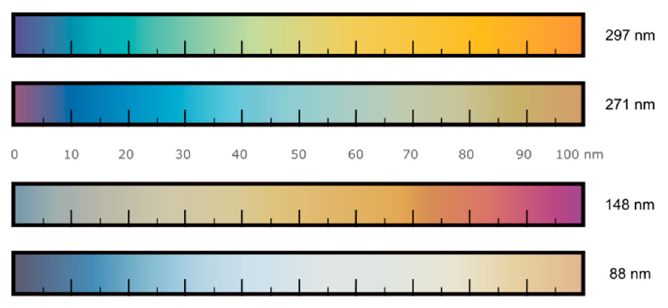
Figure 3. Thickness dependent apparent color of MoO 3 flakes on SiO 2 /Si substrates with different oxide capping layer thickness.